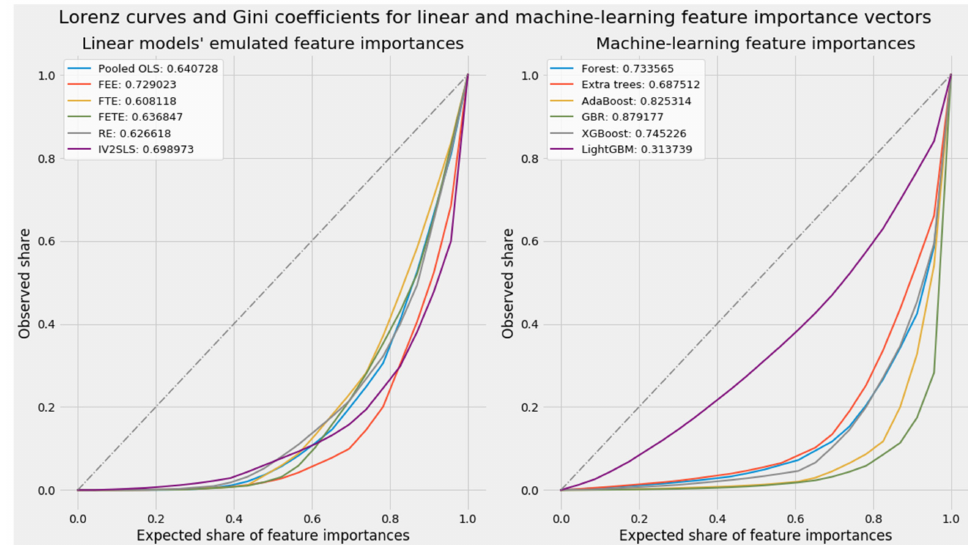
Figure 4. Lorenz curves and Gini coefficients for linear and machine learning models’ (emulated) feature importances. bbreviations—Pooled OLS: pooled ordinary least squares; FEE: fixed entity effects; FTE: fixed time effects; FETE: fixed entity and time effects; RE: random effects: IV2SLS: instrumental value/two-stage least squares; GBR: gradient boosting regression